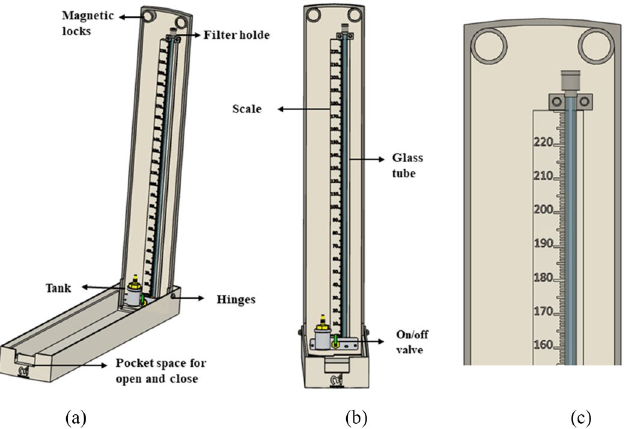
Figure 2. The CAD design of the Merkfree device. ( a ) Side view, ( b ) front view, ( c ) Inset view of the measuring scale and the